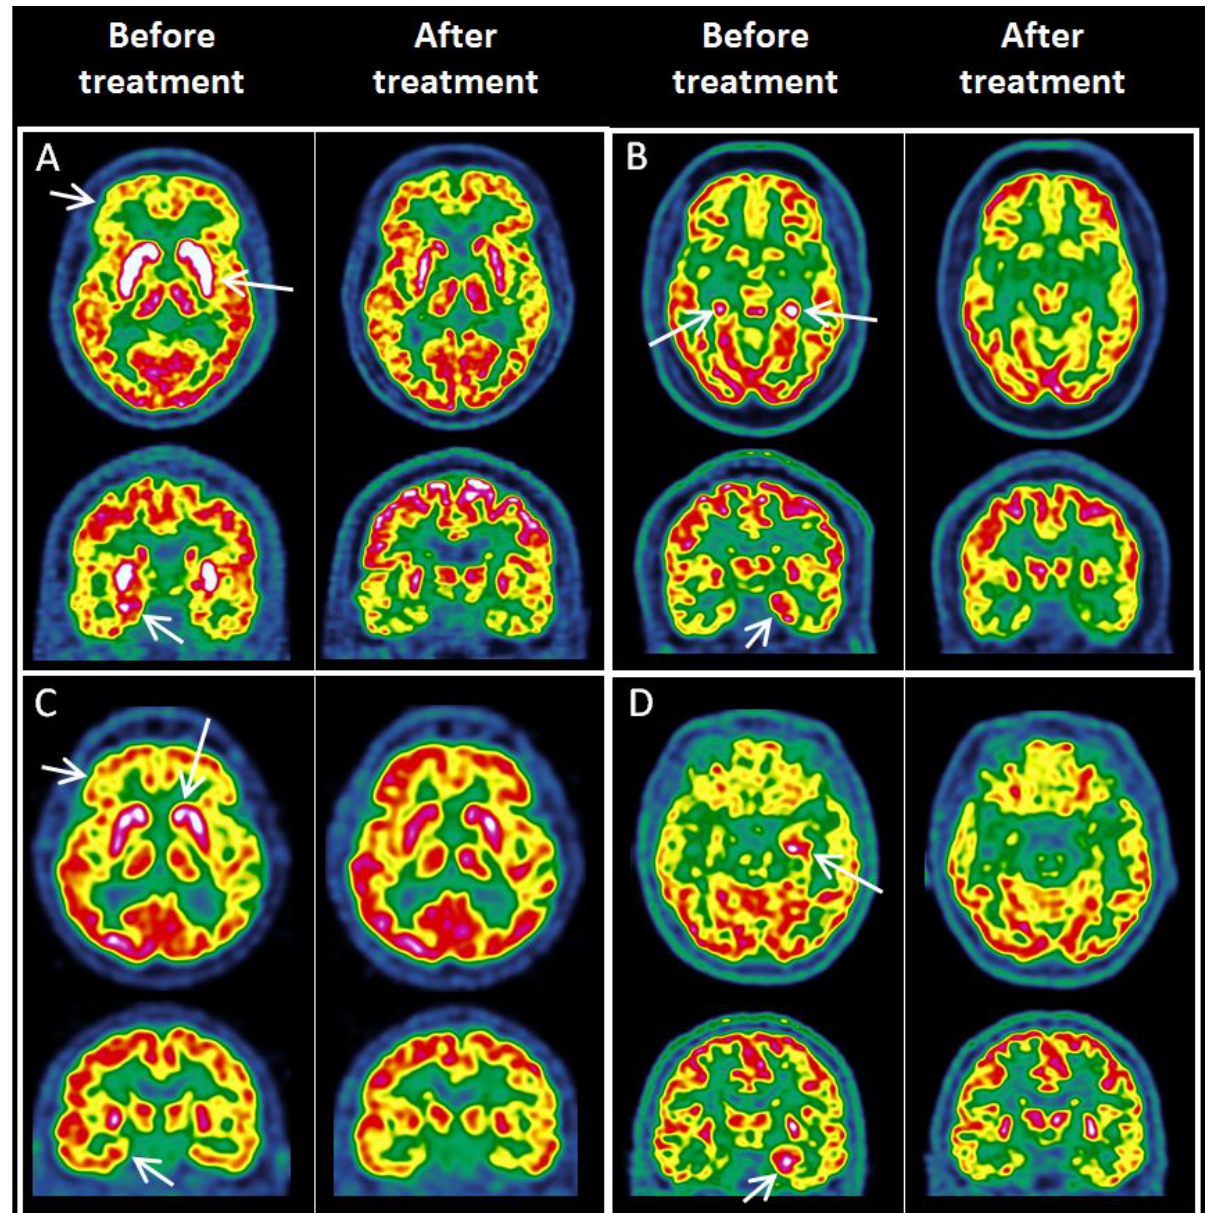
Figure 3. Examples of FDG PET images (axial and coronal sections) in patients with available post- treatment follow-up PET. White arrows indicate main metabolic abnormalities. ( A ) Patient with LGI1 AE, with initial PET showing striatum and MTL hypermetabolism and prefrontal cortex hy- pometabolism, almost normalized on follow-up PET. ( B ) Patient with anti-GAD AE, with initial PET showing bilateral MTL hypermetabolism, almost normalized on follow-up PET. ( C ) Patient with LGI1 AE, with initial PET showing striatum and MTL hypermetabolism and prefrontal cortex hy- pometabolism, completely normalized on follow-up PET. ( D ) Patient with LGI1 AE, with initial PET showing left MTL hypermetabolism, completely normalized on follow-up PET. FDG PET: 18 F-